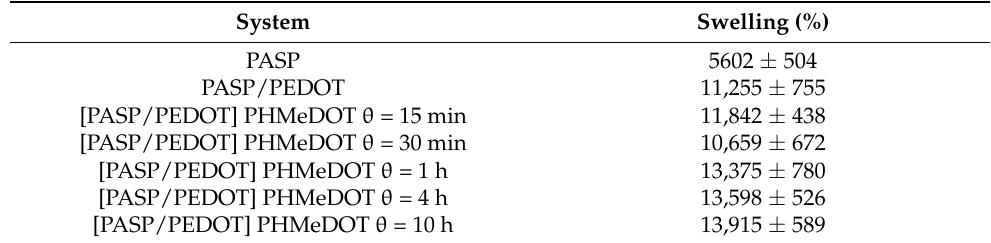
Table 1. Swelling ratio (SR, %) of PASP, PEDOT/PASP, and [PASP/PEDOT] PHMeDOT